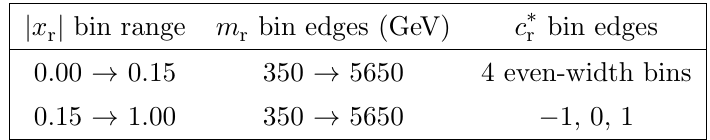
Table 6 . Template binning in the type-2 e+jets signal regions (each template has 6 total bins).